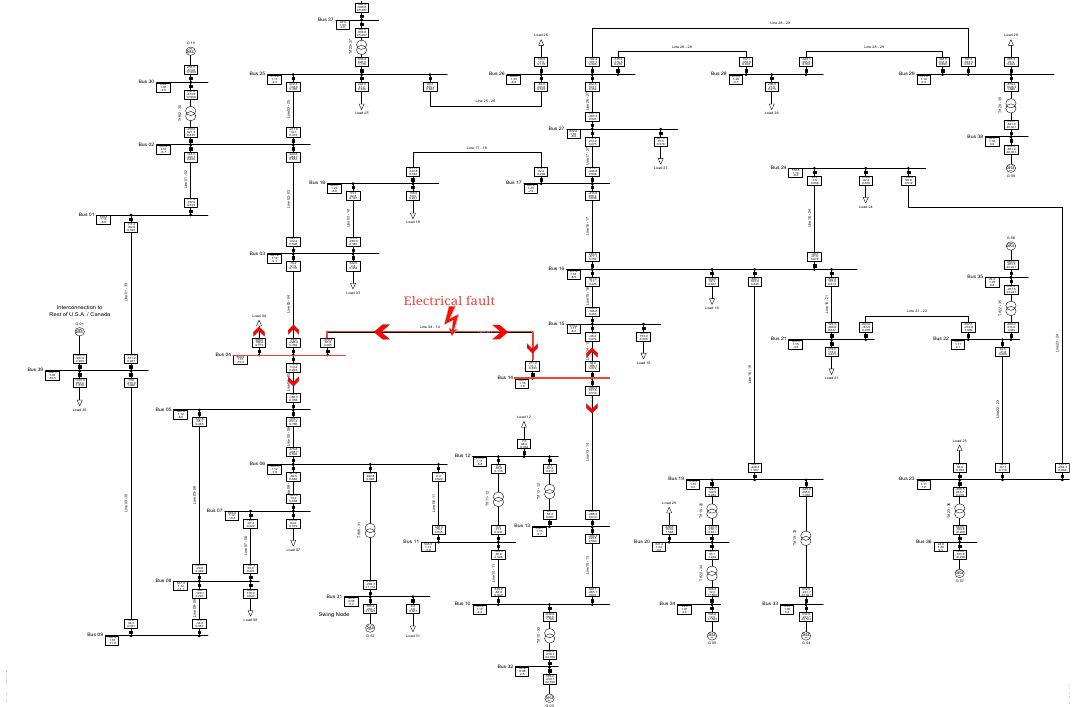
Figure 3. Electrical fault in the power system IEEE